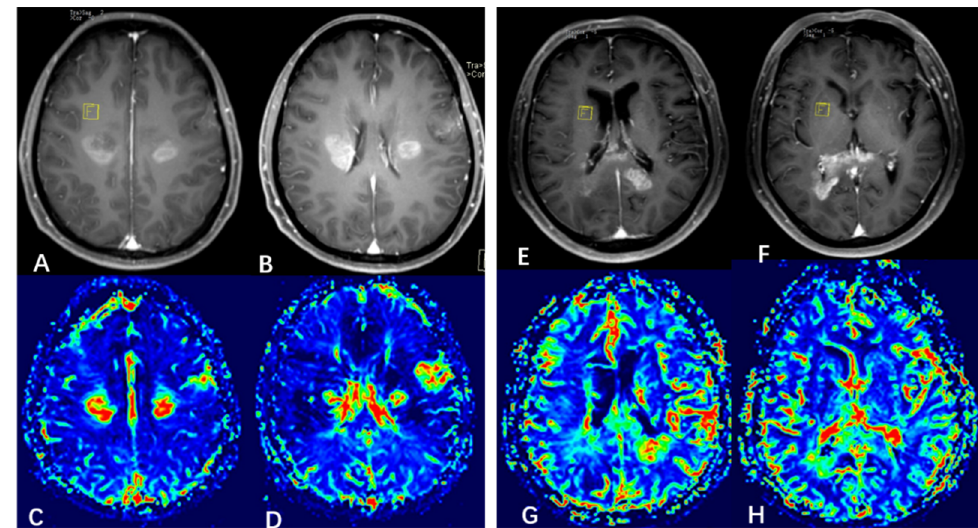
Figure 5. Illustrative cerebral blood volume (CBV) maps from the two subgroups. (( A – D ) (left panel) subgroup 1, ( E – H ) (right panel) subgroup 2). ( A , B ) Enhanced T1-weighted MRI showing 3 neoplastic foci. ( C , D ) CBV map showing elevated CBV at the foci. ( E , F ) Enhanced T1-weighted MRI showing 2 neoplastic foci. ( G , H ) CBV map showing elevated CBV at the foci.